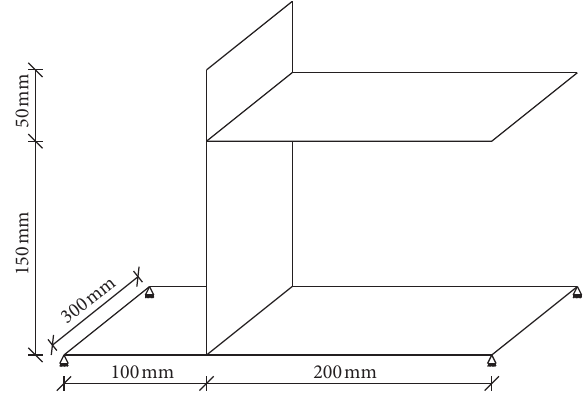
Figure 2: Illustration of the structure used in the numerical analysis.